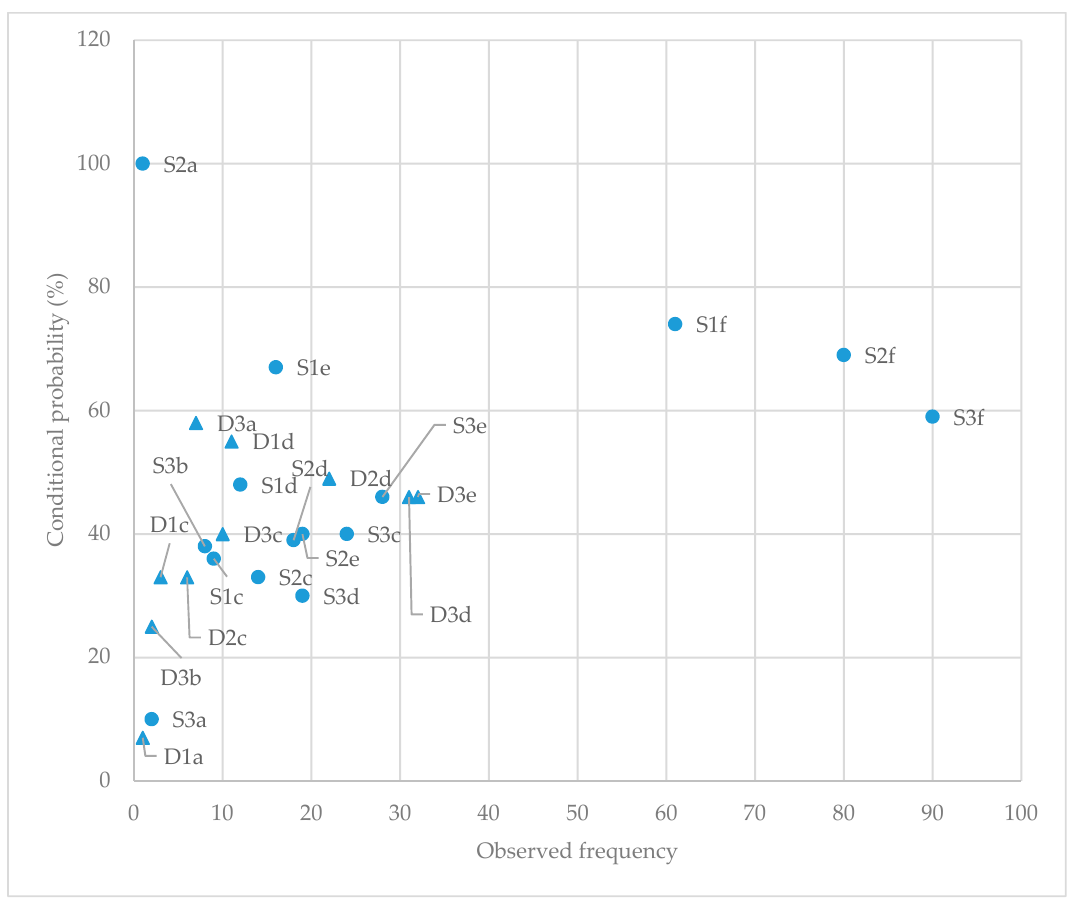
Figure 4. Significant time-based (one, two, three seconds) lag sequential analysis results (observed frequencies and conditional probabilities) for sheep behaviour response to dog behaviour and dog behaviour response to sheep behaviour. D—dog-initiated behavioural interactions (denoted by triangle); S—sheep-initiated behavioural interactions (denoted by circular dot); Number (#) denotes